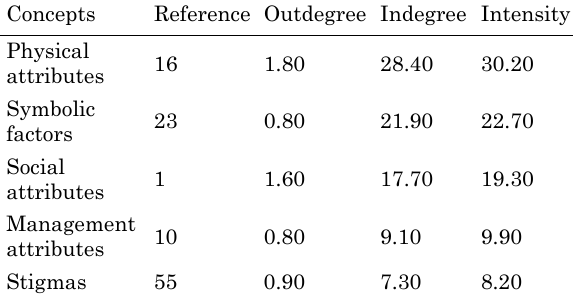
Table 1. Major determinants of neighborhood satisfaction [based on their intensity/centrality]